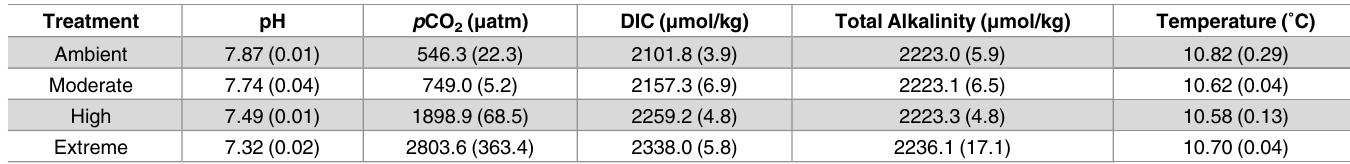
Table 1. Mean carbonate chemistryconditions ( ± standard error) in the experimental system. Shownare mean values of dissolvedorganiccarbon (DIC), total alkalinity, pH (total scale), p CO 2 , and temperature.